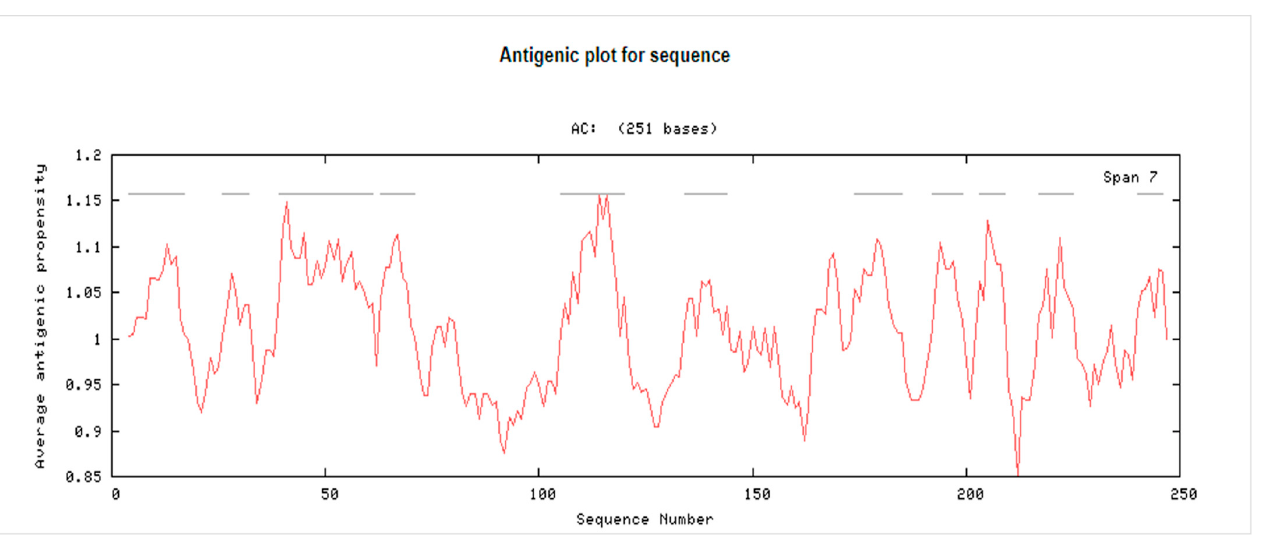
Figure 1. The antigenic propensity of reference ID 3BBA. AC: Amino acids.